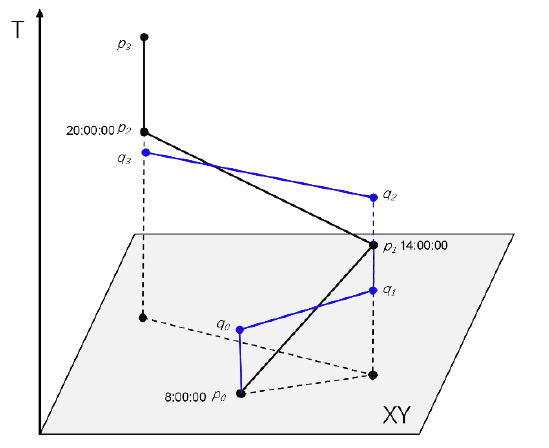
Figure 3. The adjust of move between stops